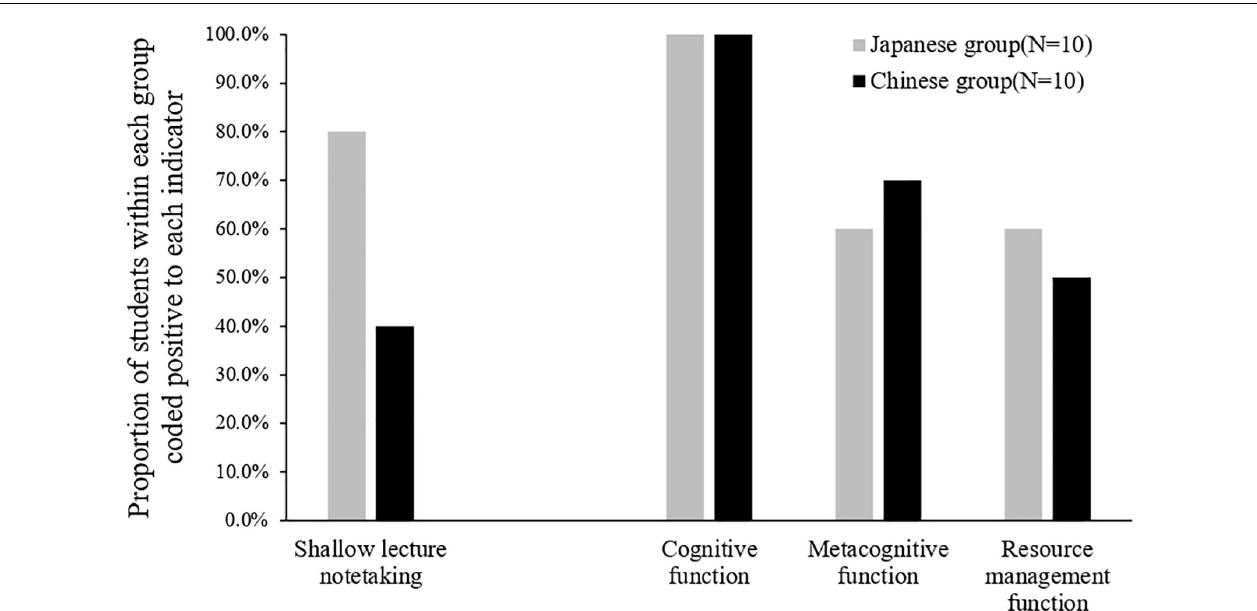
FIGURE 4 | Indicators of lecture note-taking